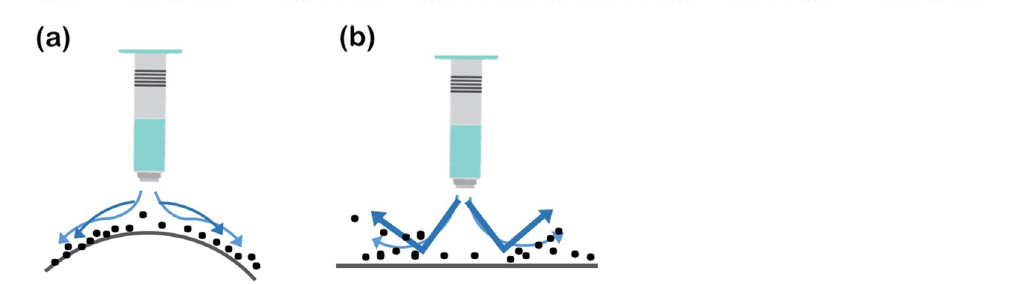
Figure 5. Principle of air pressure mirroring particle dispersion method and single-sided dispersion